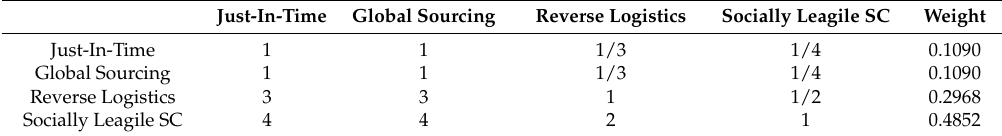
Table A2. Pairwise Comparison of Alternatives w.r.t. sub-criterion Green Design.